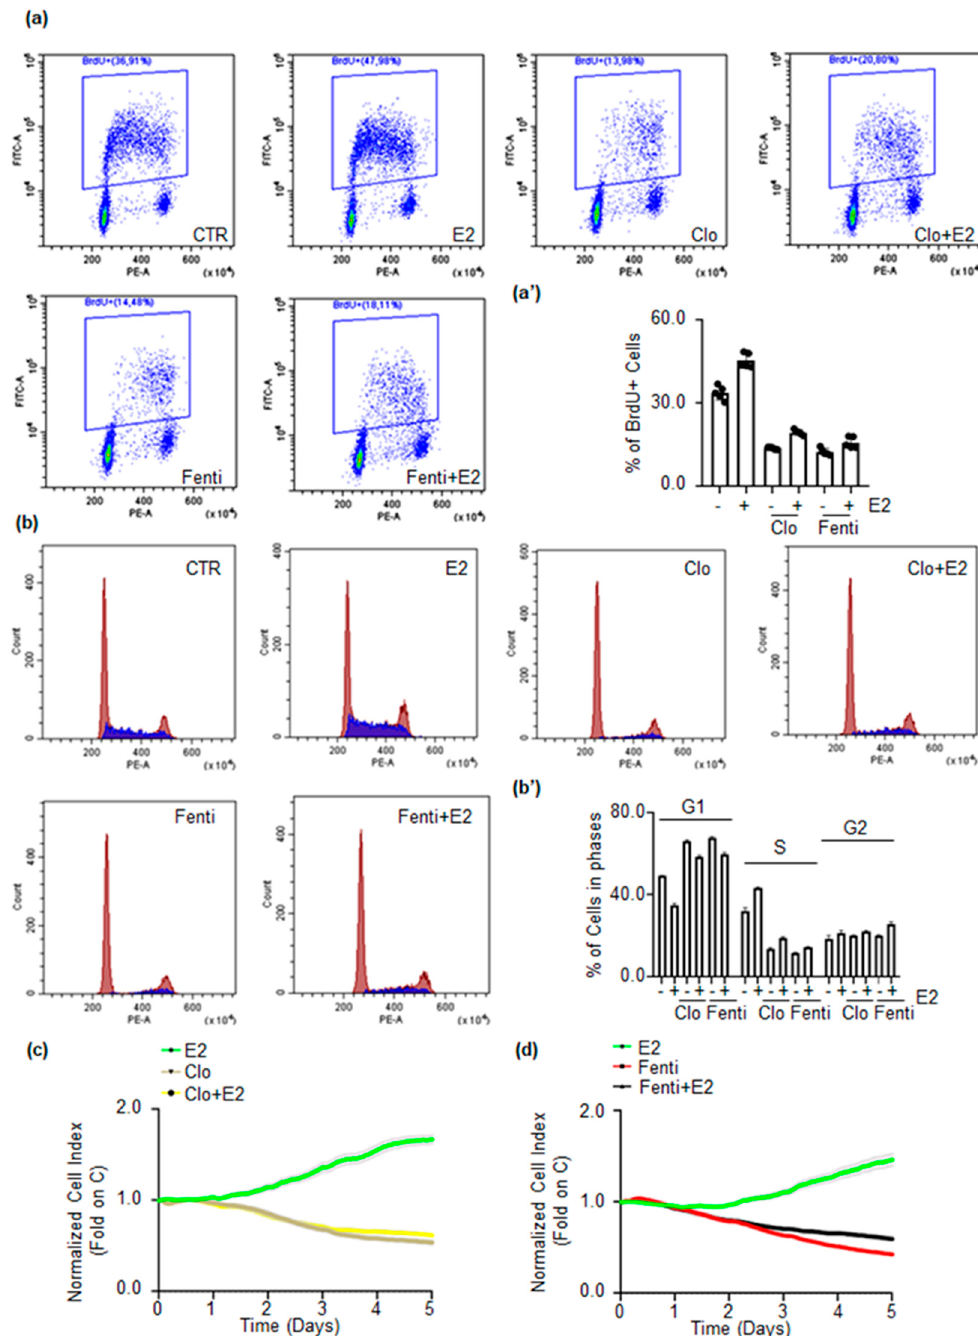
Figure 7. The impact of clotrimazole and fenticonazole on E2-induced DNA synthesis and cell proliferation. ( a , a’ ) Bromodeoxyuridine (BrdU) incorporation assay and ( b , b’ ) cell cycle analysis in MCF-7 cells treated with 17 β -estradiol (E2 1 nM–24 h) after 72 h pre-treatment with clotrimazole (Clo 10 µ M) and fenticonazole (Fenti 10 µ M). The experiments have been performed twice in duplicate. Real-time growth curves in MCF-7 cells treated with clotrimazole (Clo 10 µ M) ( c ) and fenticonazole (Fenti 10 µ M) ( d ) in the absence and the presence of 17 β -estradiol (E2 1 nM) and with E2 alone (1 nM) for the indicated time points. The graphs show Clo, Fenti, and E2 effect on the normalized cell index (i.e., cell number), which is detected with the xCelligence DP device and calculated at each time point with respect to the control sample. Each sample was measured in a quadruplicate. For details, please see the material and methods section.